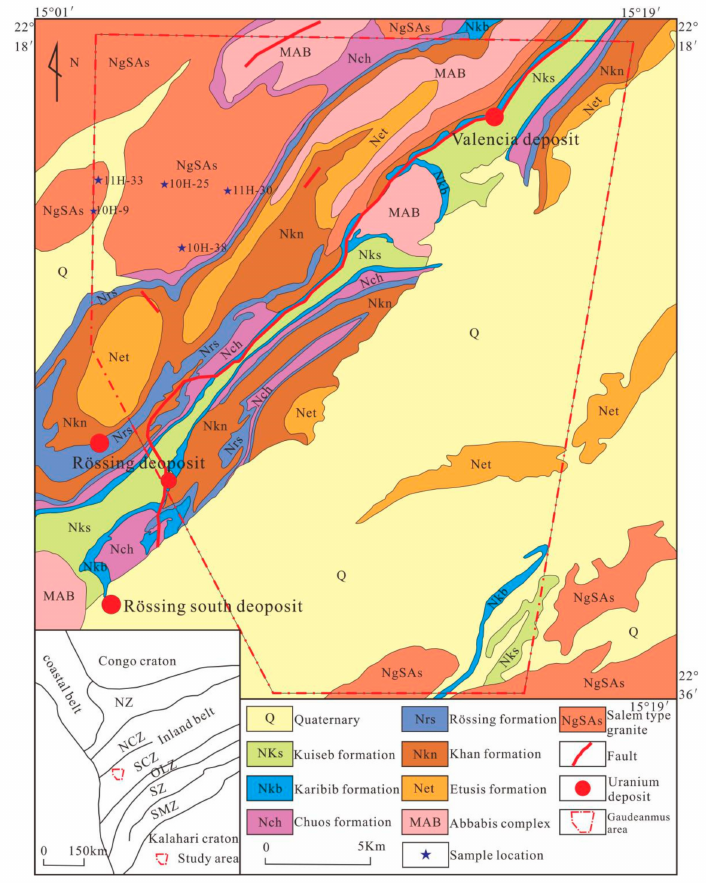
Figure 2. Geological map of Gaudeanmus area, Namibia (based on Wang et al.